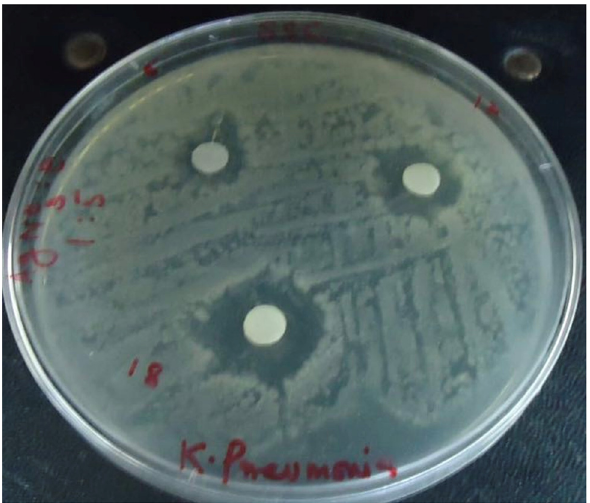
Figure A2: Antibacterial activity of AgNPs and crude methanolic extract of T. govanianum against K. pneumoniae by disc di ff usion assay.